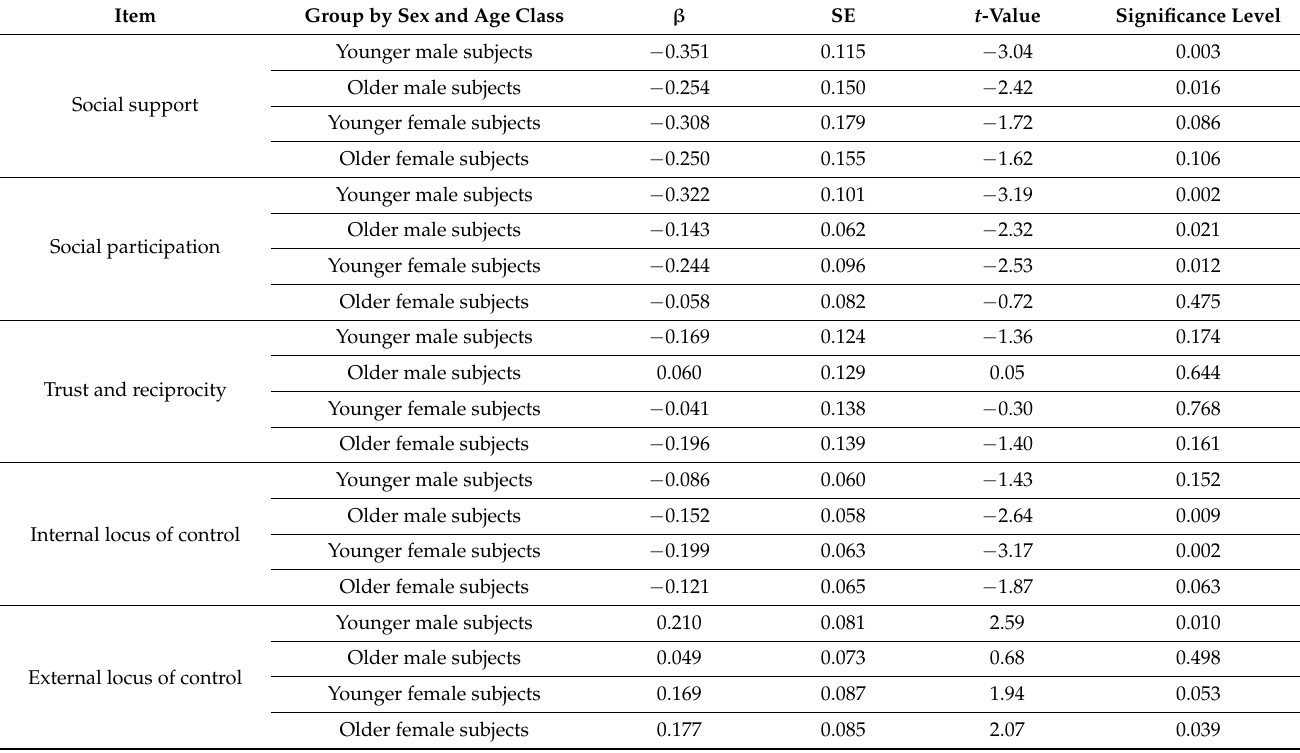
Table 2. Adjusted # regression coefficient ( β ) with its standard error (SE) on impaired physical health regarding social capital and locus of control for the four groups of objective and explanatory variables according to the four groups by sex and age classes $